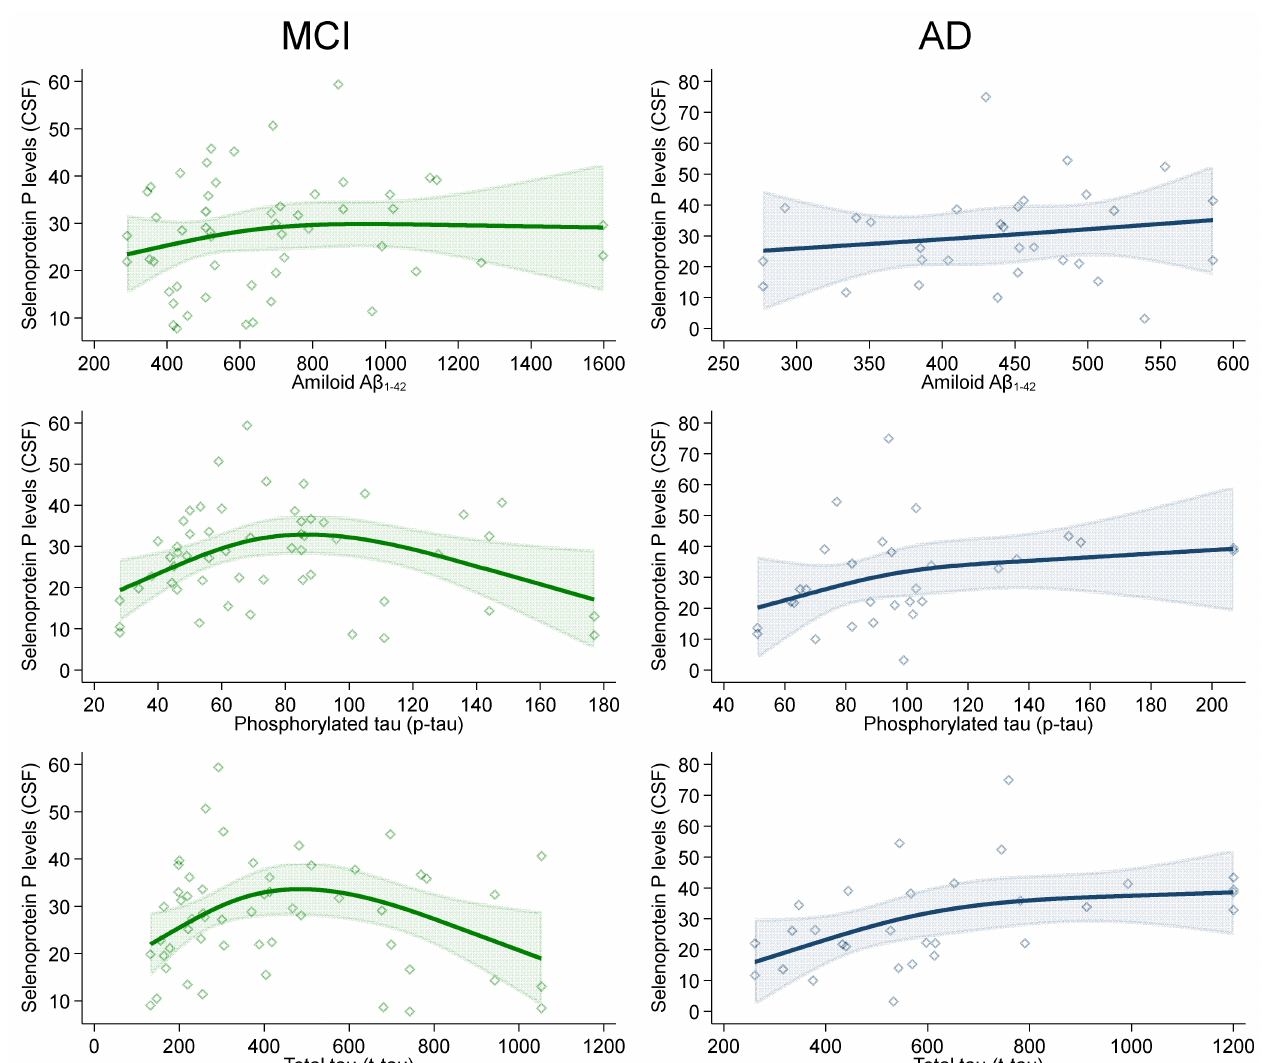
Figure 2. Association between selenoprotein P levels (ng/mL) and neurodegeneration biomarkers (ng/L) in cerebrospinal fluid (CSF) in individuals with Alzheimer’s dementia (AD) and mild cognitive impairment (MCI) in spline regression analysis adjusted for age, sex and education, with 95% confidence